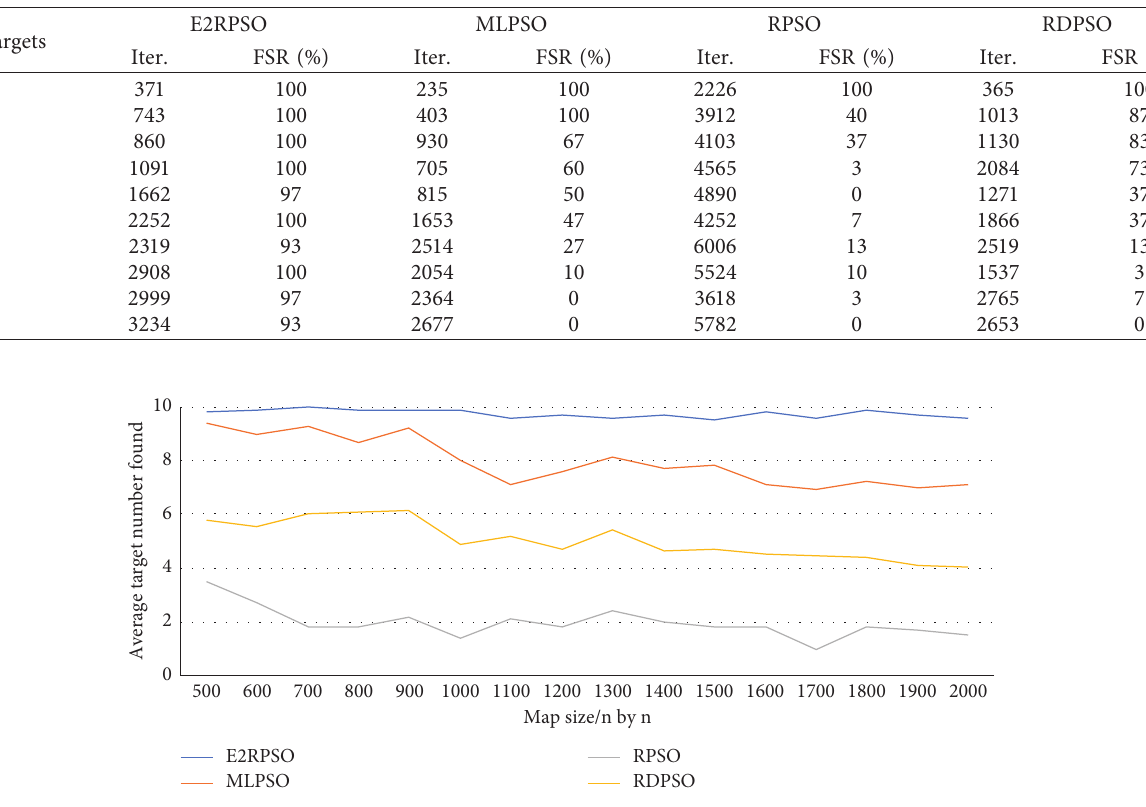
Table 4: Iteration times and full success rate (%) under different targets number.